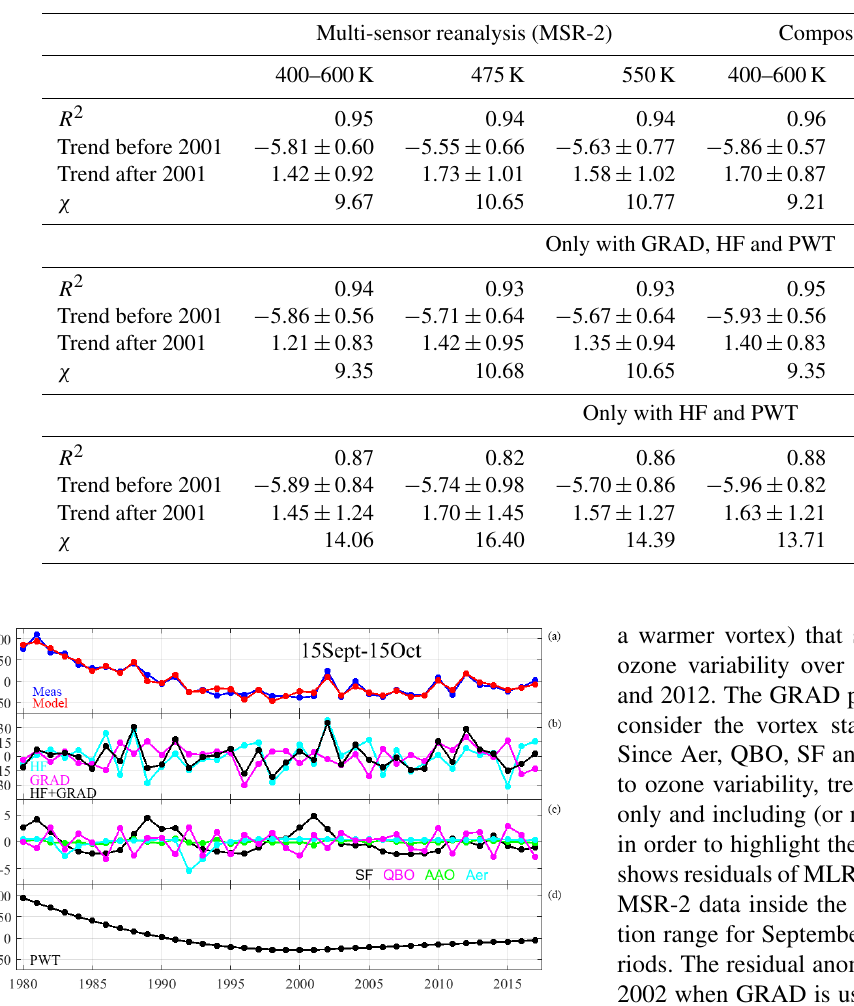
Figure 9. As in Fig. 8 but for 15 September–15